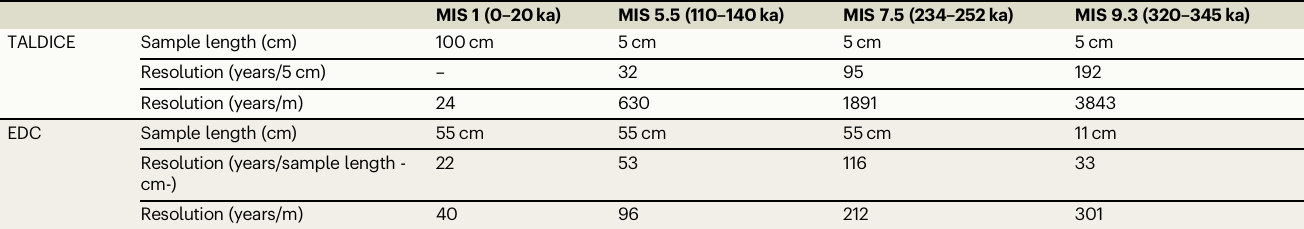
Table 2 | Comparison of temporal resolution for Talos Dome ice core (TALDICE) and Epica Dome C ice core (EDC) δ 18 O samples during interglacial